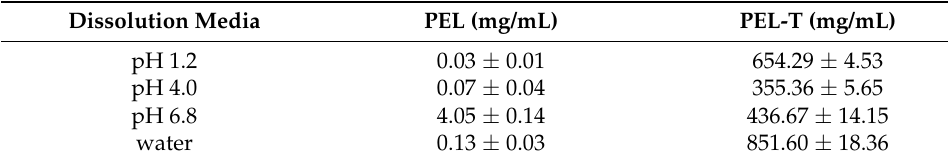
Table 2. Solubility of PEL and PEL-T at various pH values.